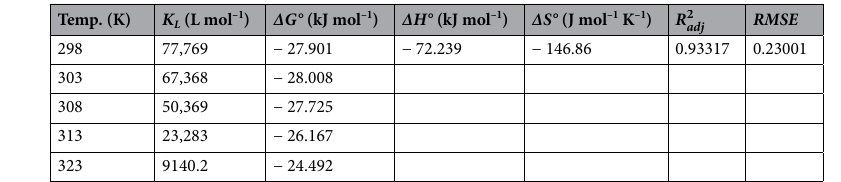
Table 3. Thermodynamic characteristics of the adsorption process. Conditions: initial pH of the solution = 2; mass of adsorbent = 0.05 mg; temperature = 25–50 °C; agitation time = 1 h; initial concentration of Congo red = 0.02–3 g L –1 ; volume of Congo red = 20 mL; and agitation speed = 160 rpm.